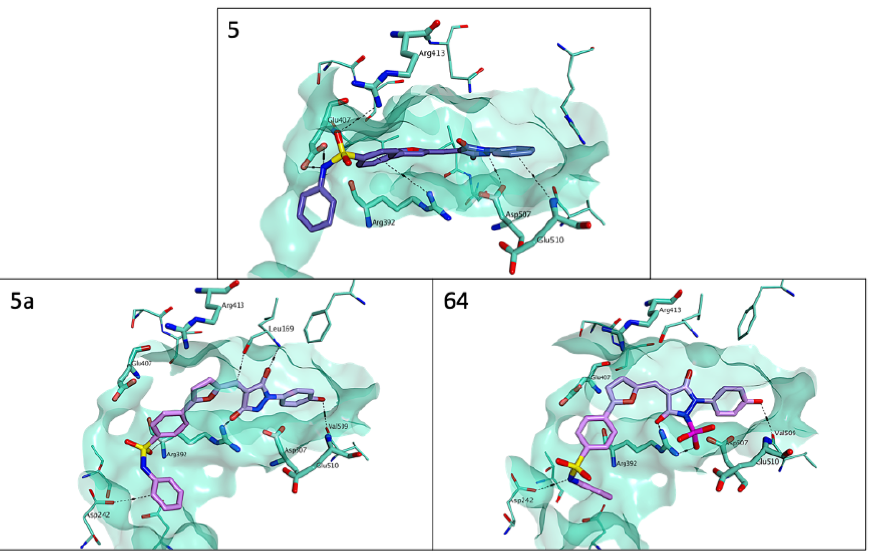
Figure 9. Proposed binding mode for 5 (carbon atoms in purple), 5a and 64 (carbon atoms in lilac) to the human norovirus RdRp (PDB ID 4LQ3). The binding site area is represented as green molec- ular surface. Human norovirus RdRp is represented as green ribbon, with carbon atoms in green. Black dashed lines represent non-bonded interactions (e.g., hydrogen bonds, electrostatic interactions) between the ligand and the amino acid residues of the protein.